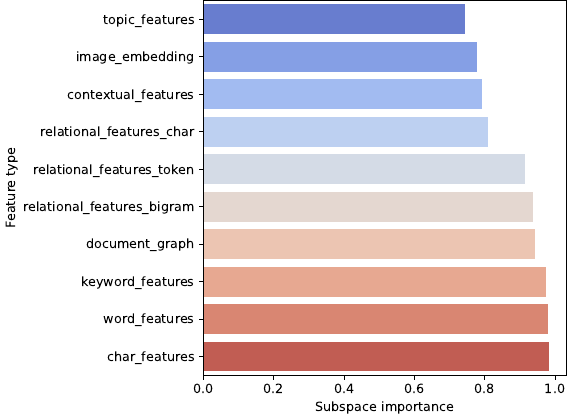
Figure 3. Weights of different feature subspaces— tasty . For this dataset, image-only classifiers perform poorly—this is also apparent in the joint space considered by MuRE; here, image embeddings have low final weights relative to text-based ones. Character and token features are the most relevant for this problem (text-only learning is a strong